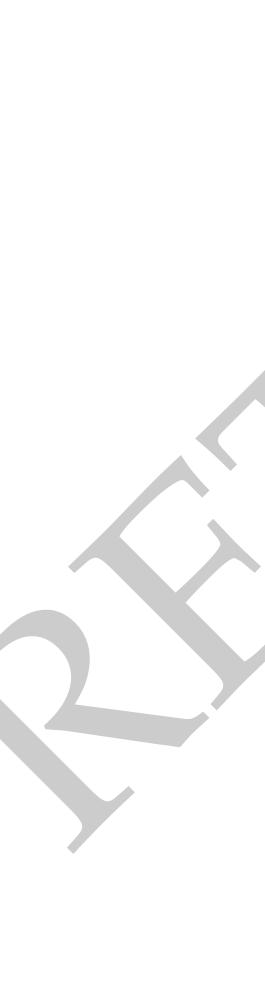
Figure 1. Genomewide distribution ( A ). The x -axis represents the chromosome position. The y -axis indicates the average coverage reads. ( B ) Total RNA extracted from leaves of WT and SR was used for RT-PCR analysis with gene-specific primers as listed in Table S2.